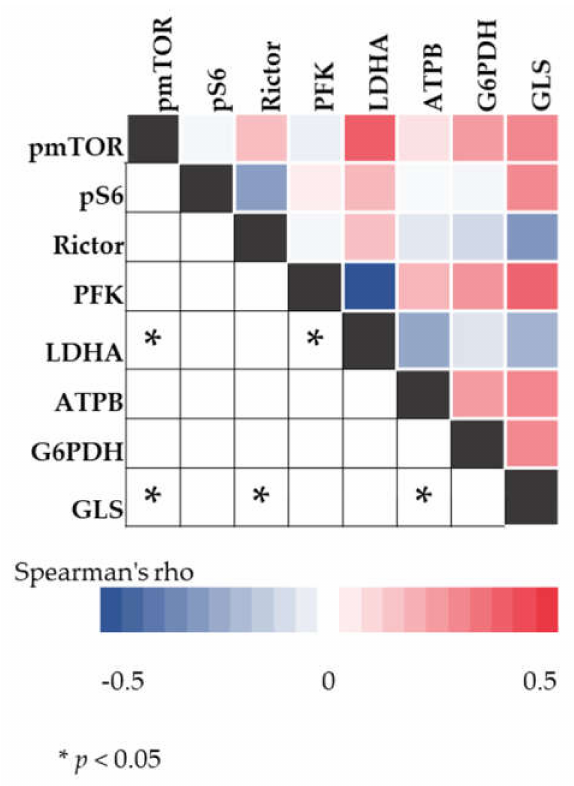
Figure 6. The results of the Spearman correlation analysis. The color intensity of heatmap changes according to the belonging Spearman’s rho value. The asterisks mark the significant ( p < 0.05)